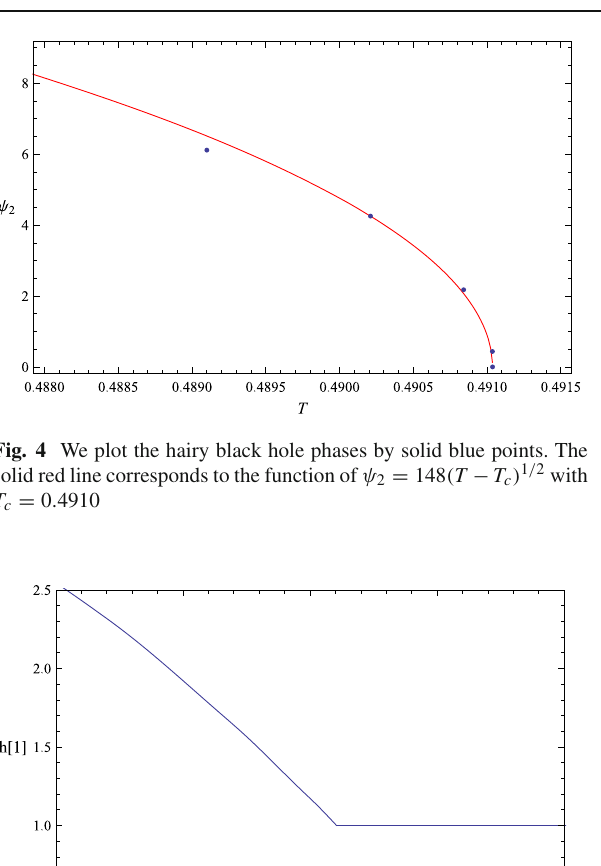
In the right panel, we show the critical temperature T c as a function of the scalar mass m 2 with q = 100 and μ = 0 .